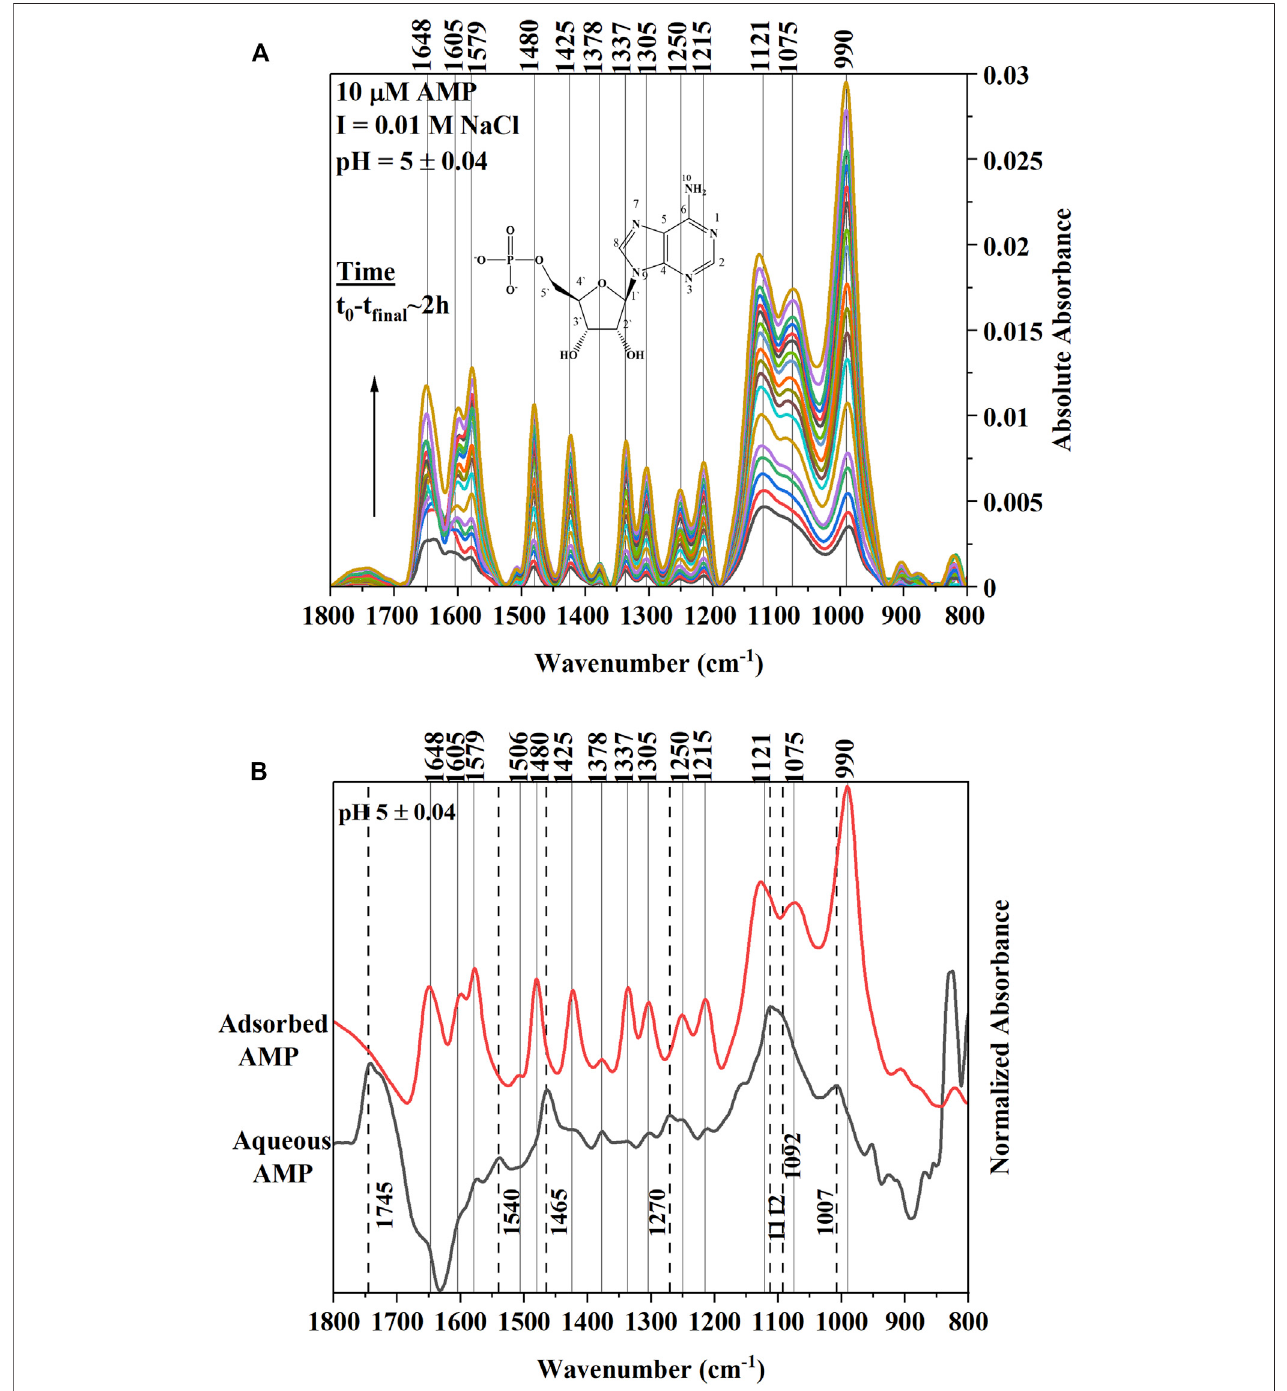
FIGURE 1 | (A) (Upper Panel) Time series in situ ATR-FTIR spectra of 10 µM AMP adsorption on hematite at ionicstrength of0.01 M NaCl and pH 5.0 ± 0.04. The t 0 -t fi nal indicates approximately thetimeinterval of collecting fi rst and the last IR spectraafter addition ofAMP in the reaction mixture. The Y axis is indicating the absolute value of the IR absorbance. The inset is a representative of chemical structure of AMP. (B) (Lower Panel) Final equilibrated spectrum of 10 µM AMP stacked on top of aqueous AMP spectrum collected at similar pH (5.0 ± 0.04) and ionic strength values. Both spectra were normalized with respect to the highest IR band in the 1,800 – 800 cm − 1 range to compare. Dotted lines are connecting the IR bands related to aqueous AMP spectrum.